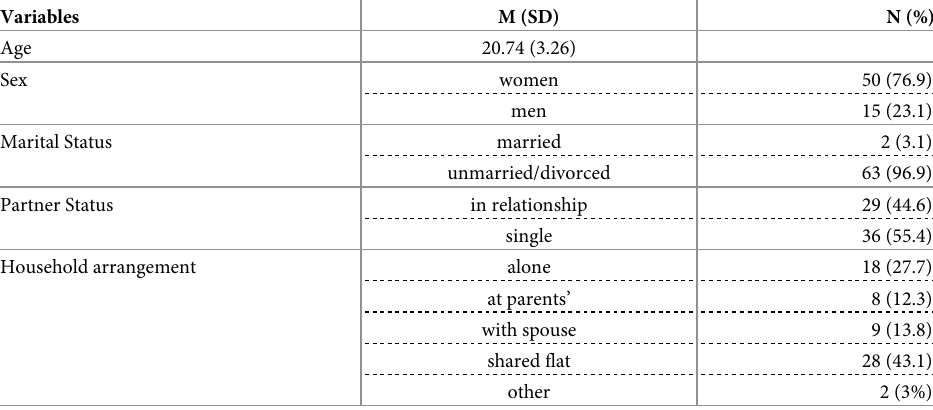
Table 1. Descriptive statistics for key study